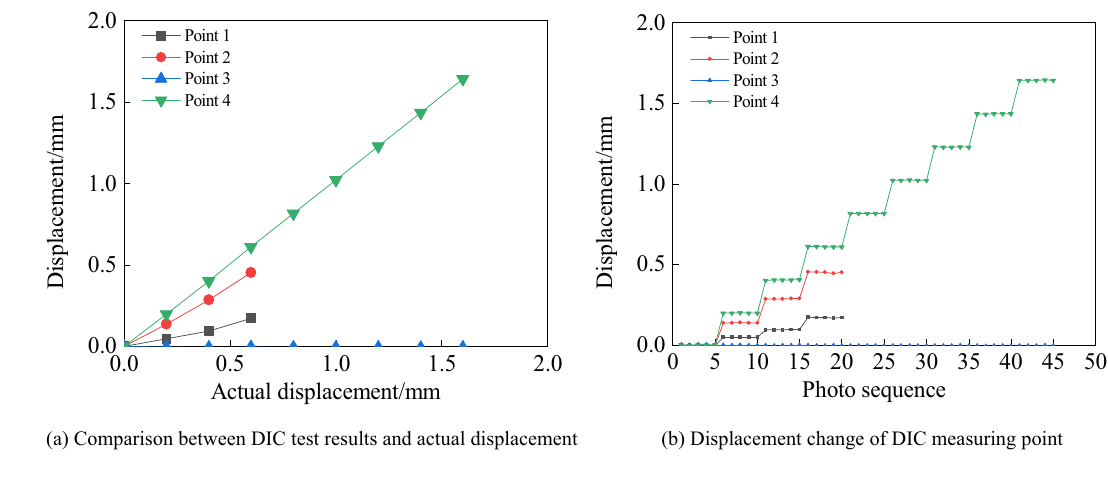
Figure 9. DIC measurement